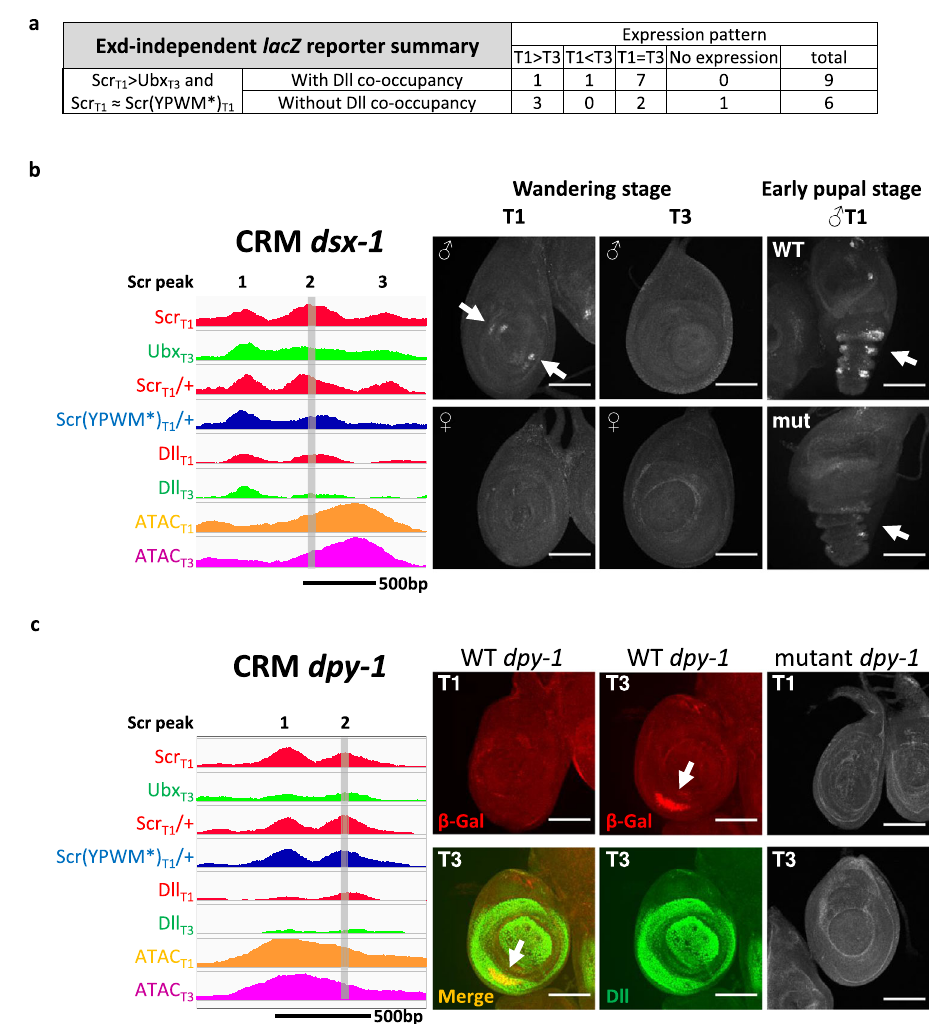
Fig. 8 Reporters generated from Exd-independent Scr T1 > Ubx T3 peaks. a Table summarizing the leg disc expression patterns driven by selected